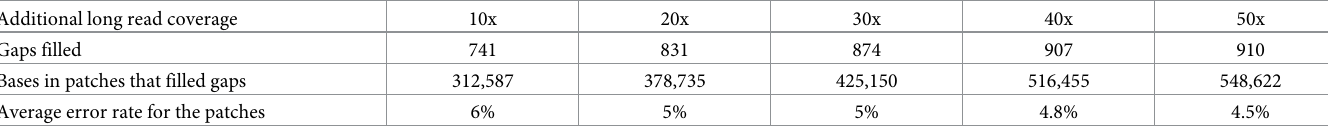
Table 2. Evaluation of the completeness and the consensus quality of the Arabidopsis assemblies after scaffolding with PacBio data with SAMBA. We computed the average consensus quality of the gap-filling sequences for different levels of long-read coverage based on the number of mismatches, insertions and deletions reported by QUAST before and after scaffolding. Because more gaps were closed at higher coverage, the average error rate of the patches decreased only marginally. Additional long read coverage 10x 50x Gaps filled 741 910 Bases in patches that filled gaps Average error rate for the